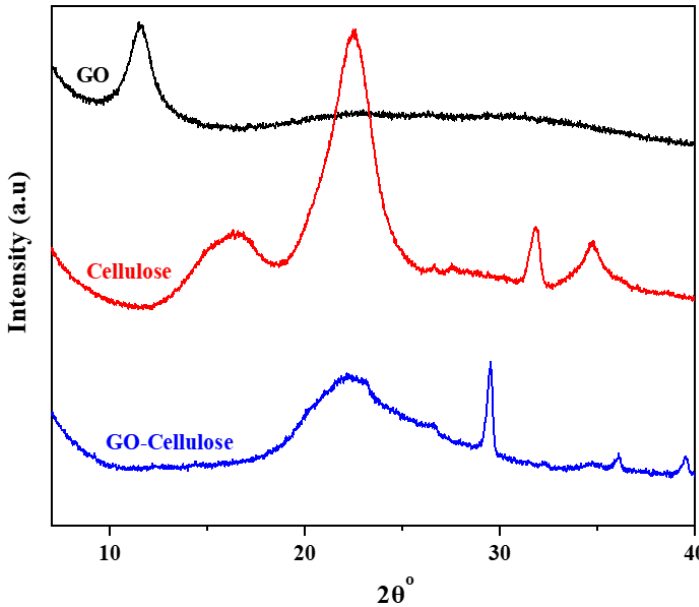
Figure 2. XRD patterns of GO, extracted cellulose, and GO–cellulose composite.